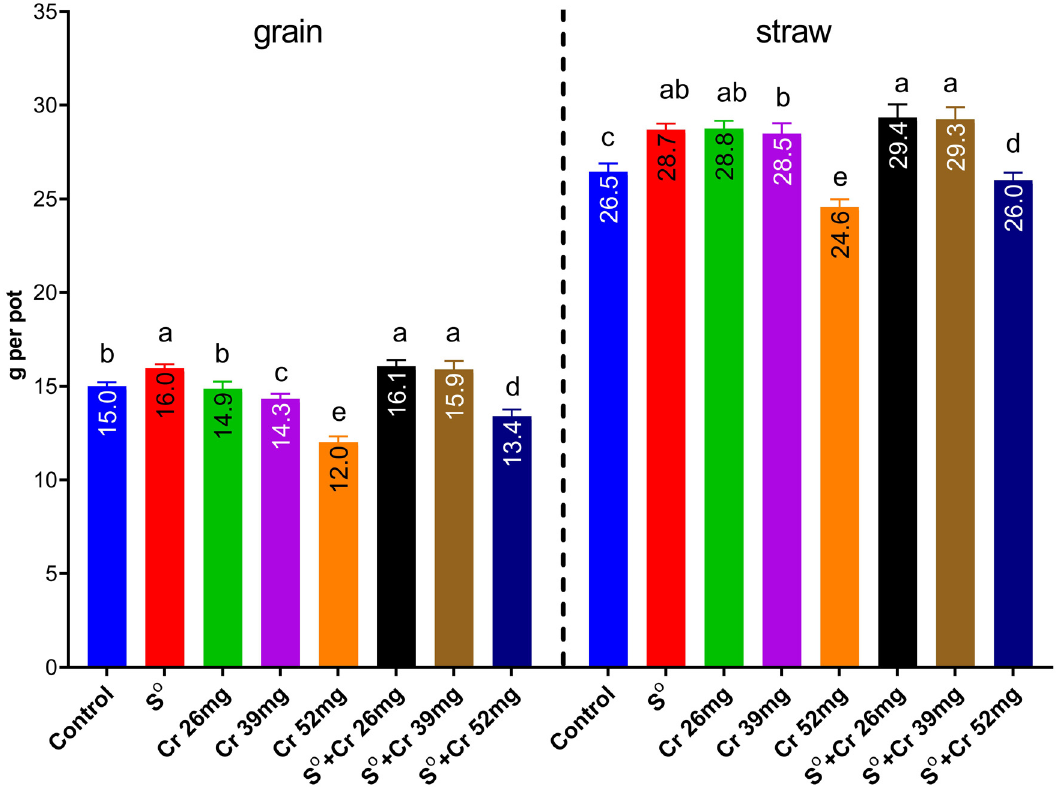
Figure 2: Yield of spring wheat.